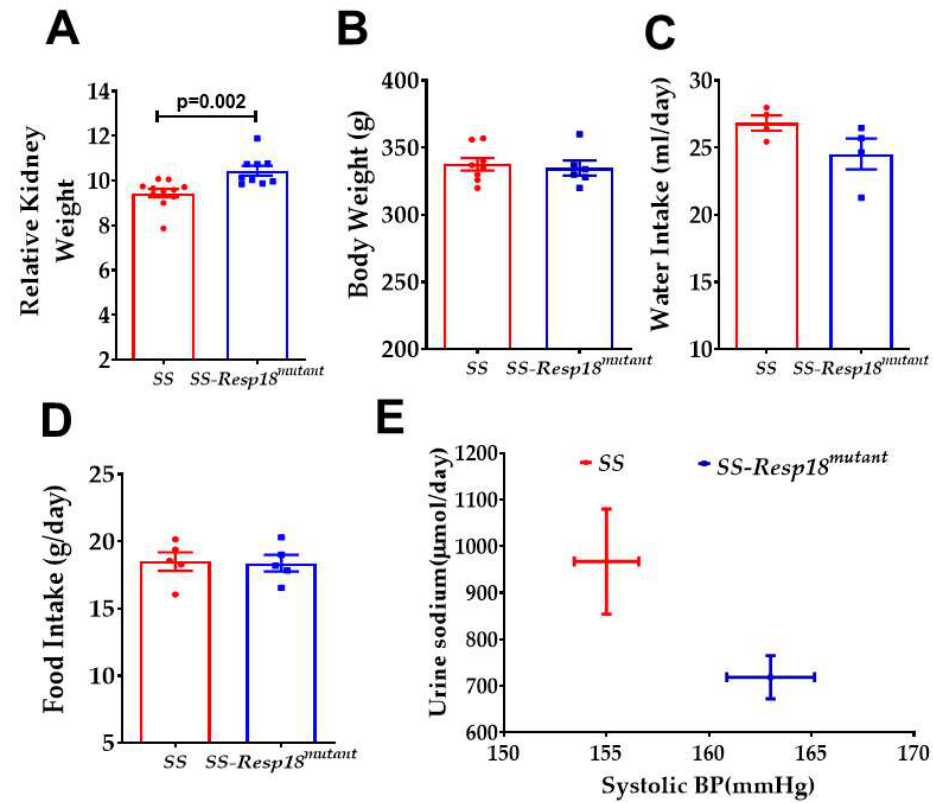
Figure 3. SS- Resp18 mutant rats’ pressure–natriuresis is shifted down and to the right; relative kidney weight is increased in SS- Resp18 mutant rats: ( A ) relative kidney (kidney weight/body weight) ( n = 9–11), ( B ) body weight ( n = 9–11) ( C ) water intake ( n = 4), and ( D ) food intake ( n = 4) were measured in both SS and SS- Resp18 mutant rats six weeks after high-salt diet. ( E ) Relationship between sodium excretion and blood pressure after six weeks on a high-salt diet. Data are mean ± SEM. p = 0.002, vs. SS- Resp18 mutant , t -test.